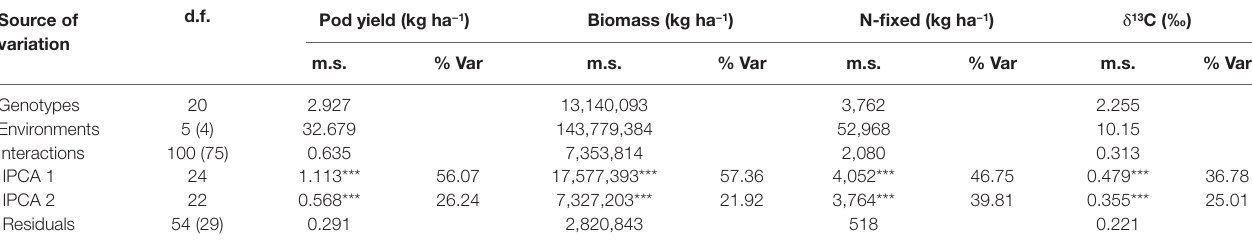
TABLE 5 | ANOVA table for AMMI model applied to pod yield, shoot biomass, N-fixed, and shoot δ 13 C values of groundnut genotypes tested in six environments. d.f. Pod yield (kg ha −1 ) Biomass (kg ha −1 Source of variation